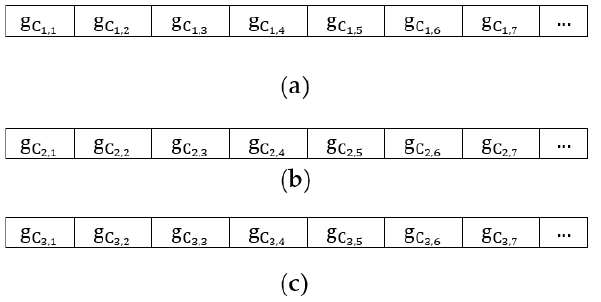
Figure 2. Production of the matrices for three classes: ( a ) Class C 1 ; ( b ) Class C 2 ; ( c ) Class C 3 . To insert the data, after classifications of host image pixels, matrix pixels C y (y = 1, 2, 3) are divided into non-overlapping blocks with a size of 1 × 5. The vector P is then created for pixels of each block to calculate the different values for both consecutive pixels, according to Figure 3.